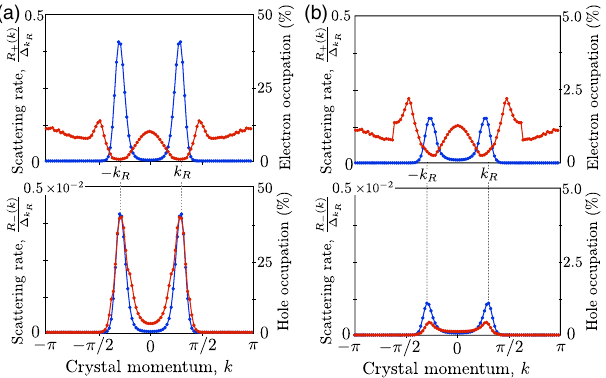
FIG. 6. Scattering rates (red) R α ð k Þ [see Eq. (D6)] in the steady state of the system. The top (bottom) plot corresponds to the upper (lower) Floquet band. Also shown (blue) are the distribu- k Þ an n k Þ in each Floquet band. In (a), we show the tions n e ð h ð case of half filling, with no reservoir coupling (corresponding to Fig. 3 in the main text), while in (b) we take log 10 ð ϒ Þ ¼ 3 . 15 . Other model parameters are the same as for the green (middle) curve in Fig. 3. Note the enhanced scale for the rates in the bottom plots and the enhanced scale for the distributions in